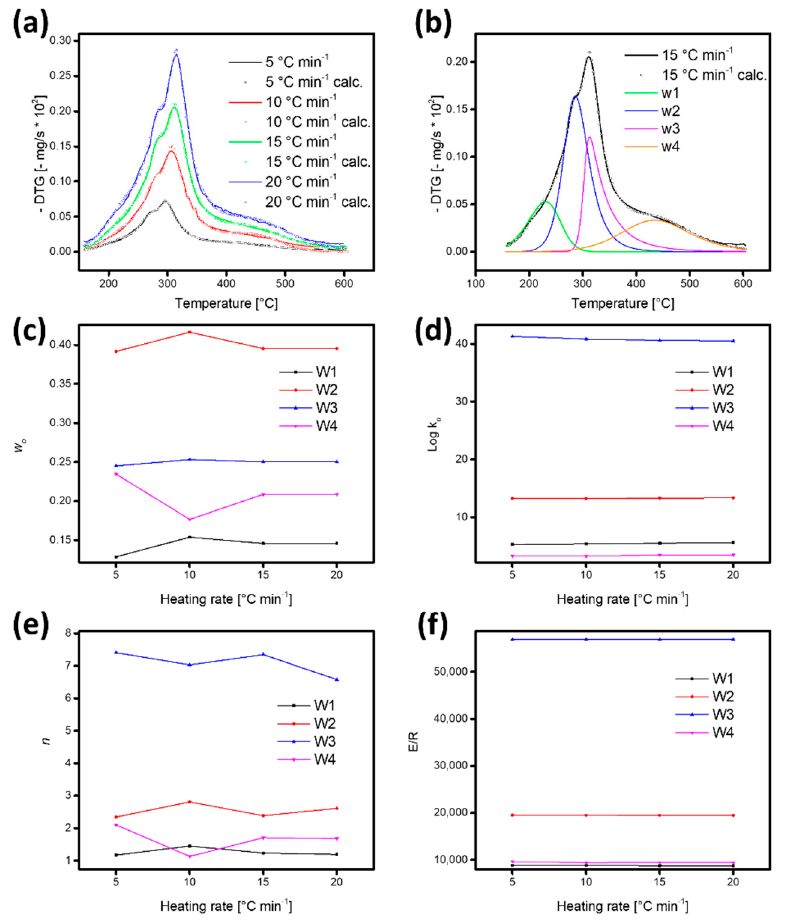
Figure 2. Individual fit of CPH thermal decomposition experiments in inert atmosphere for each heating rate. ( a ) comparison of experimental and calculated data, ( b ) example of the four fractions obtained in the fitting at 15 ◦ C min − 1 , ( c ) variation of the w o values, ( d ) variation of the log k o values, ( e ) variation of the n values, ( f ) variation of the E/R values.